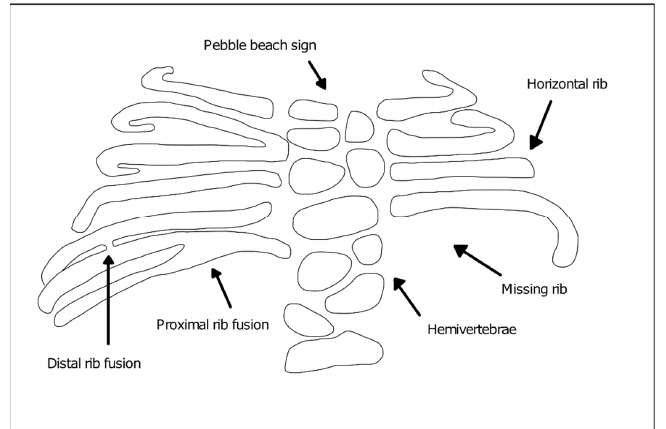
Figure 1. Vertebral and rib malformations identified in different types of spondylocostal dysostosis (SCDO). Genetics and Main Phenotypic Characteristics of SCDO Subtypes